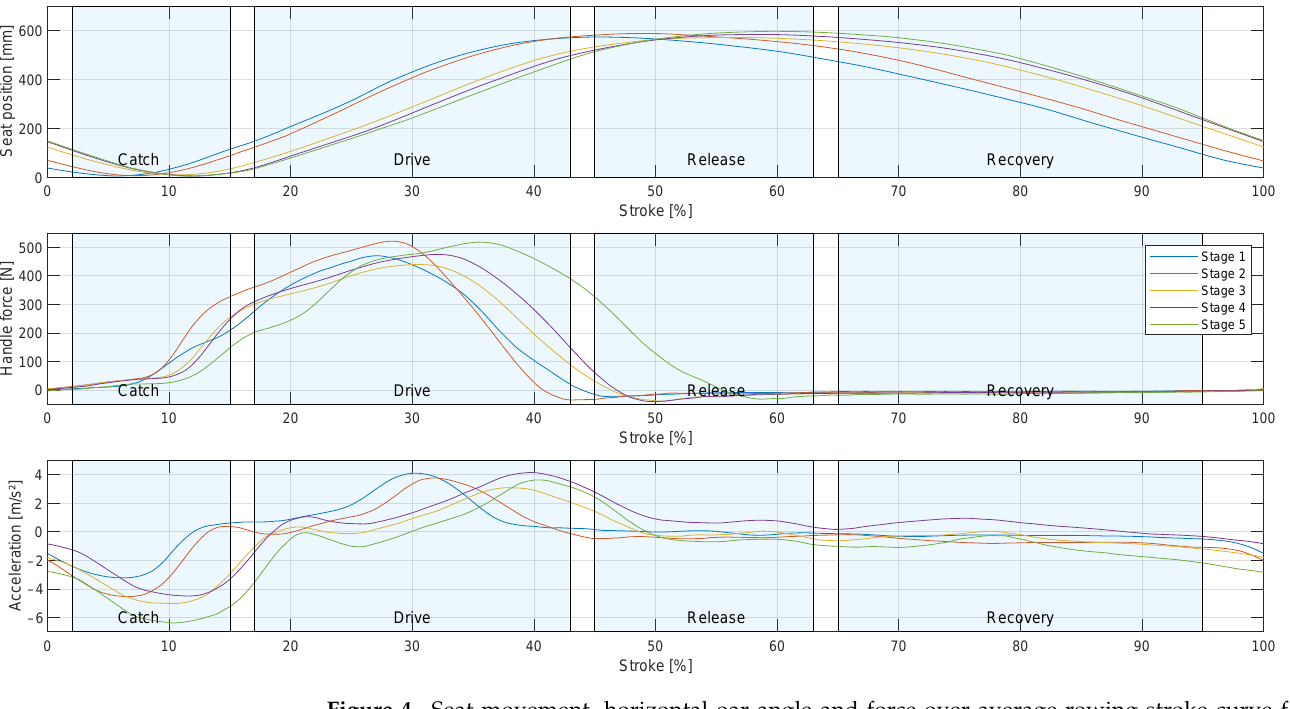
Figure 4. Seat movement, horizontal oar angle and force over average rowing stroke curve for different stages during the training. Blue areas mark rowing phases.